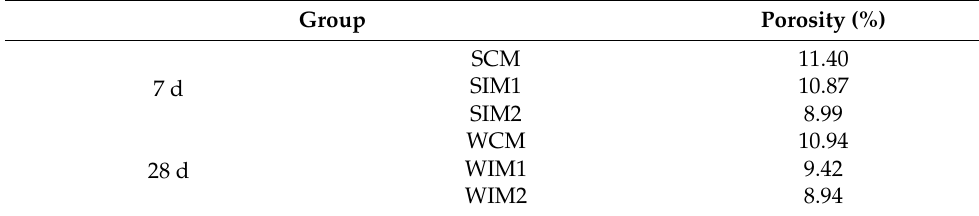
Table 6. NMR analysis results of porosity.